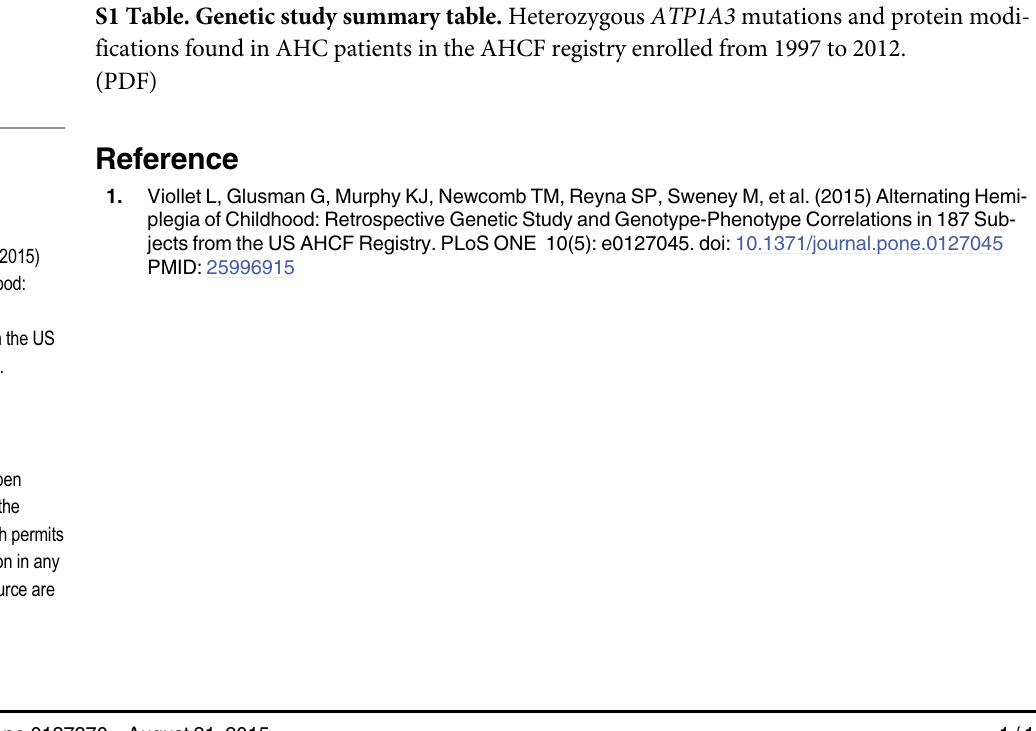
S1 Table. Genetic study summary table. Heterozygous ATP1A3 mutations and protein modi- fications found in AHC patients in the AHCF registry enrolled from 1997 to